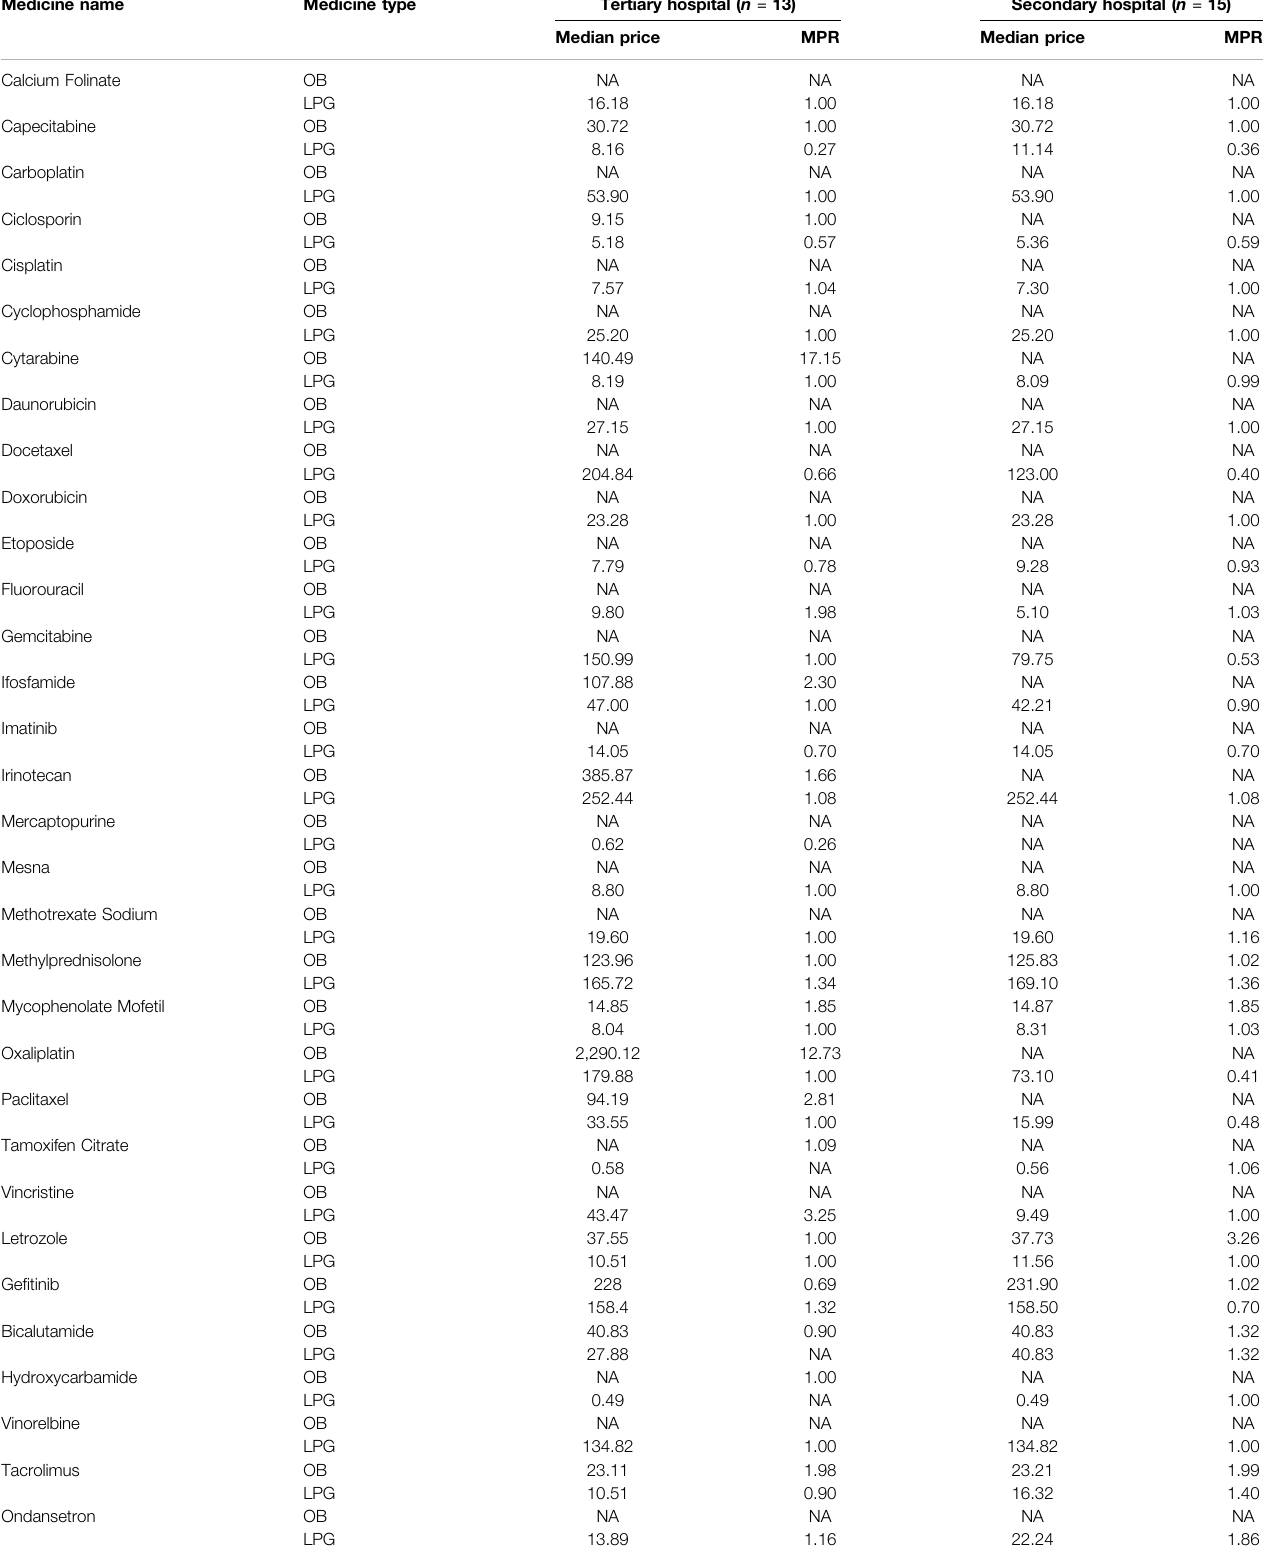
TABLE 3 | The median patient price and MPR of anticancer medicines in tertiary and secondary hospitals in Hubei Province. Medicine name